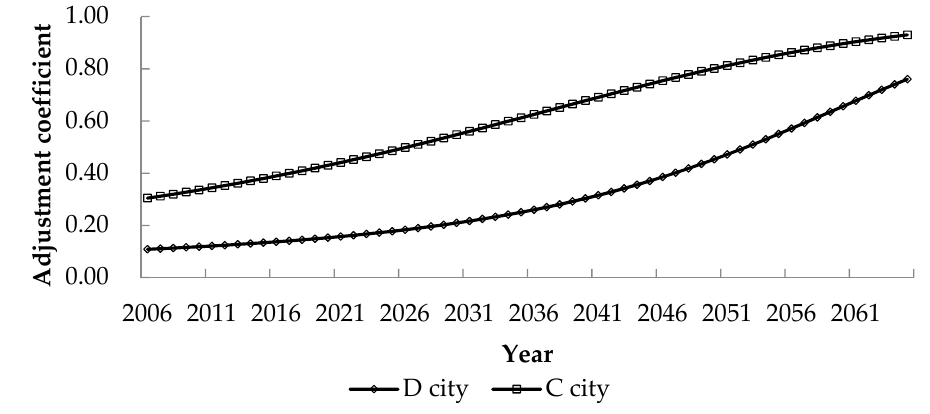
Figure 2. Adjustment coefficient of compensation standard for beneficiaries in C city and D city.